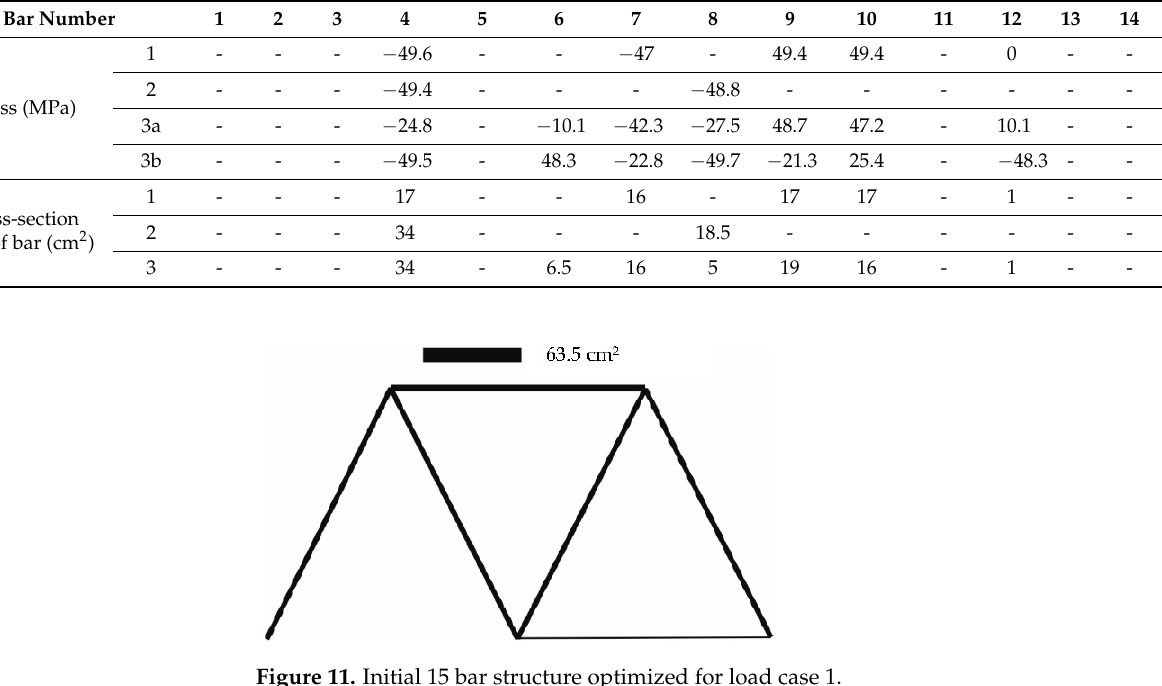
Table 6. Stresses and cross-sectional areas in bars of an initial 15 bar structure, state after optimization.